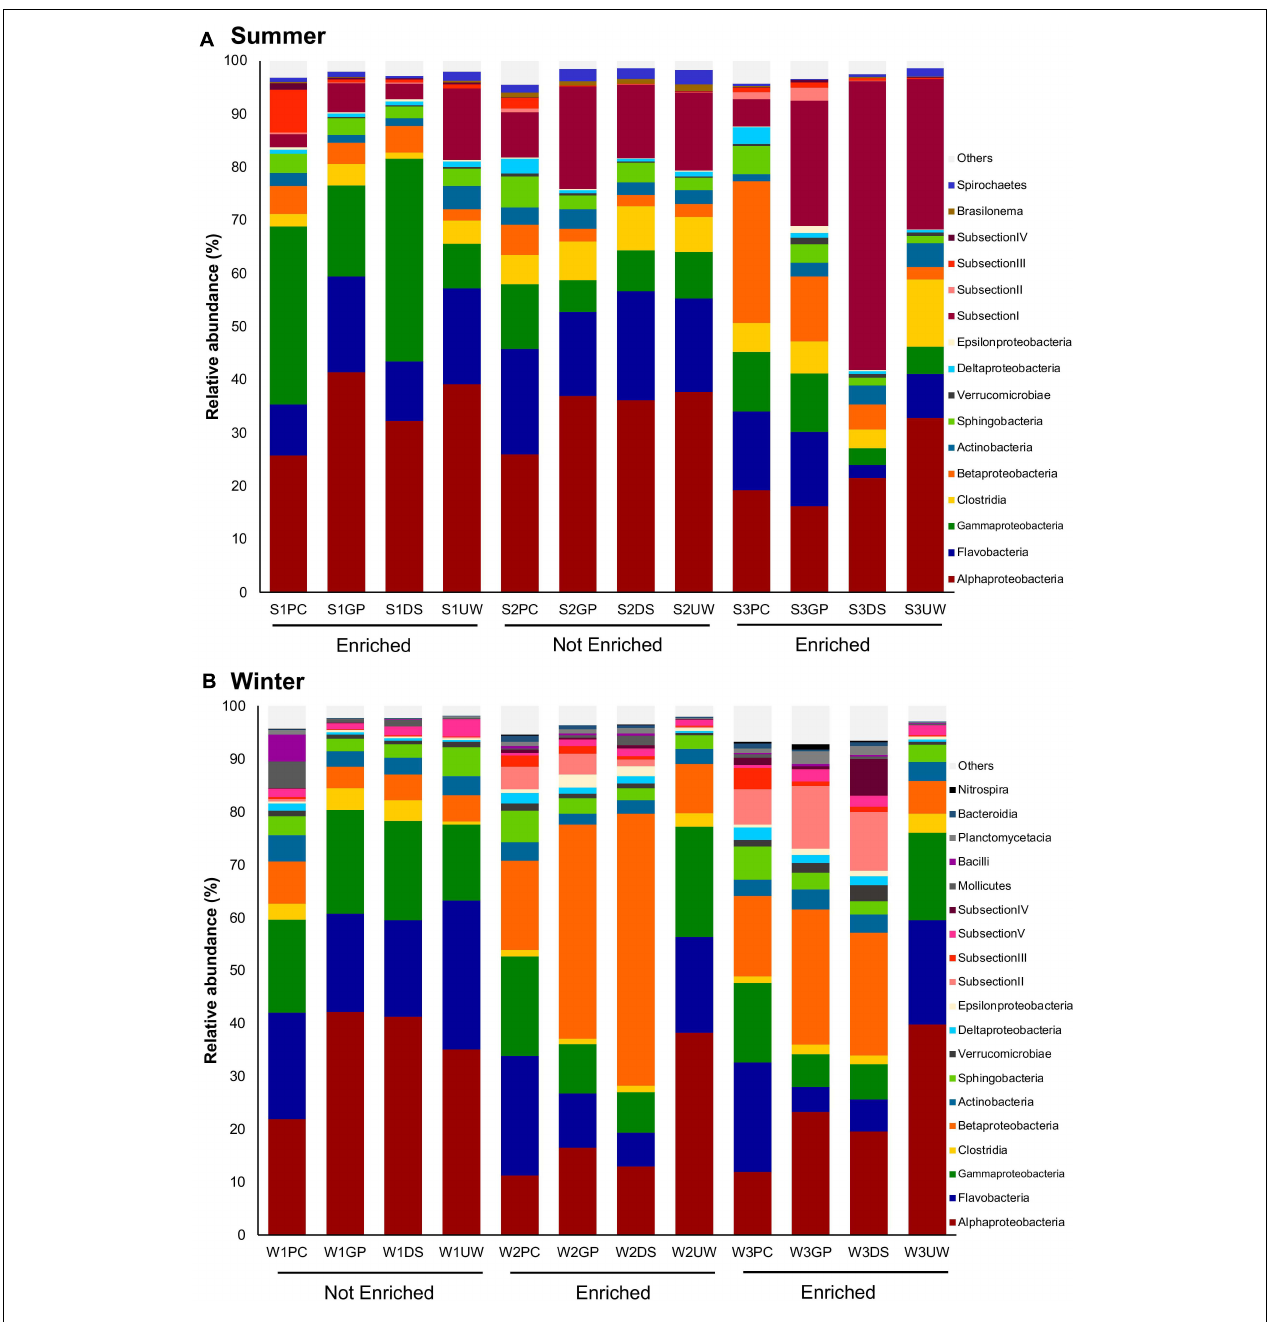
FIGURE 3 | Relative abundances of bacterial groups in the SML (PC, GP, DS) and UW at class level. Only groups with relative abundances greater than 0.5% for any of the samples in (A) summer (S) and (B) winter (W) are shown. “Others” comprises groups with relative abundances < 0.5% for all